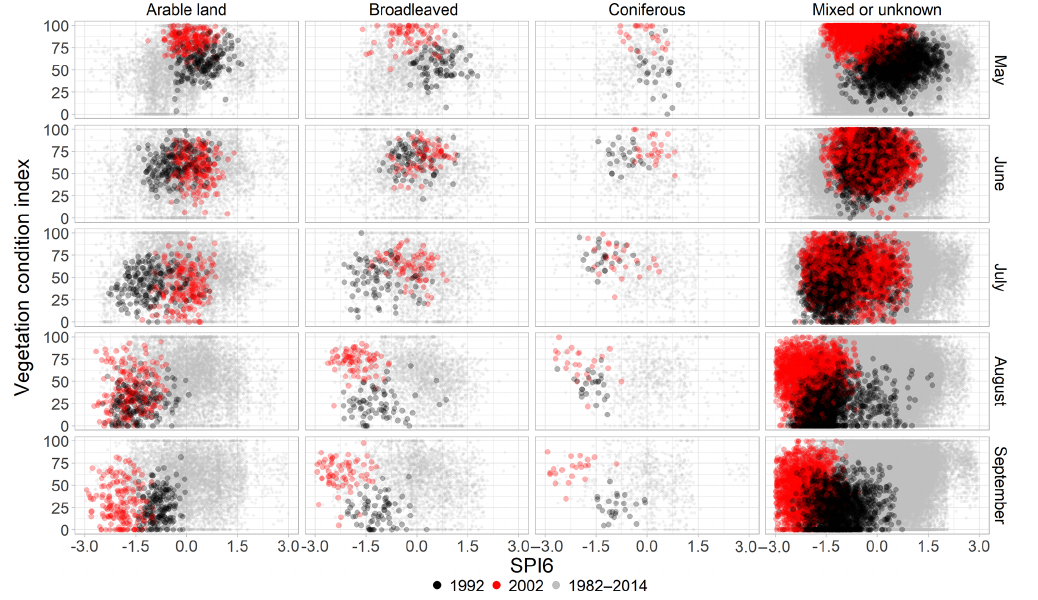
Figure 6. Relationship between SPI6 and VCI for different land use types during the normal (1982–2014) and dry (1992, 2002)